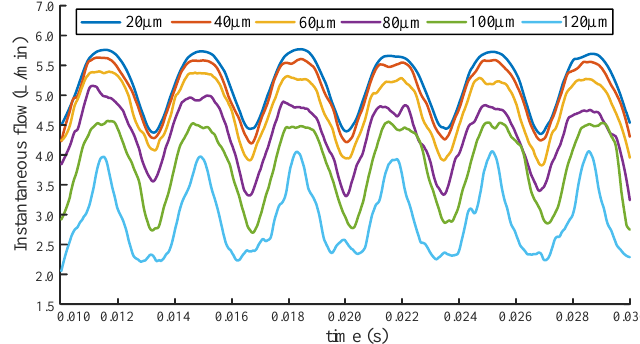
Figure 10. Comparison graph of instantaneous simulation flow rate under different radial wear gaps.